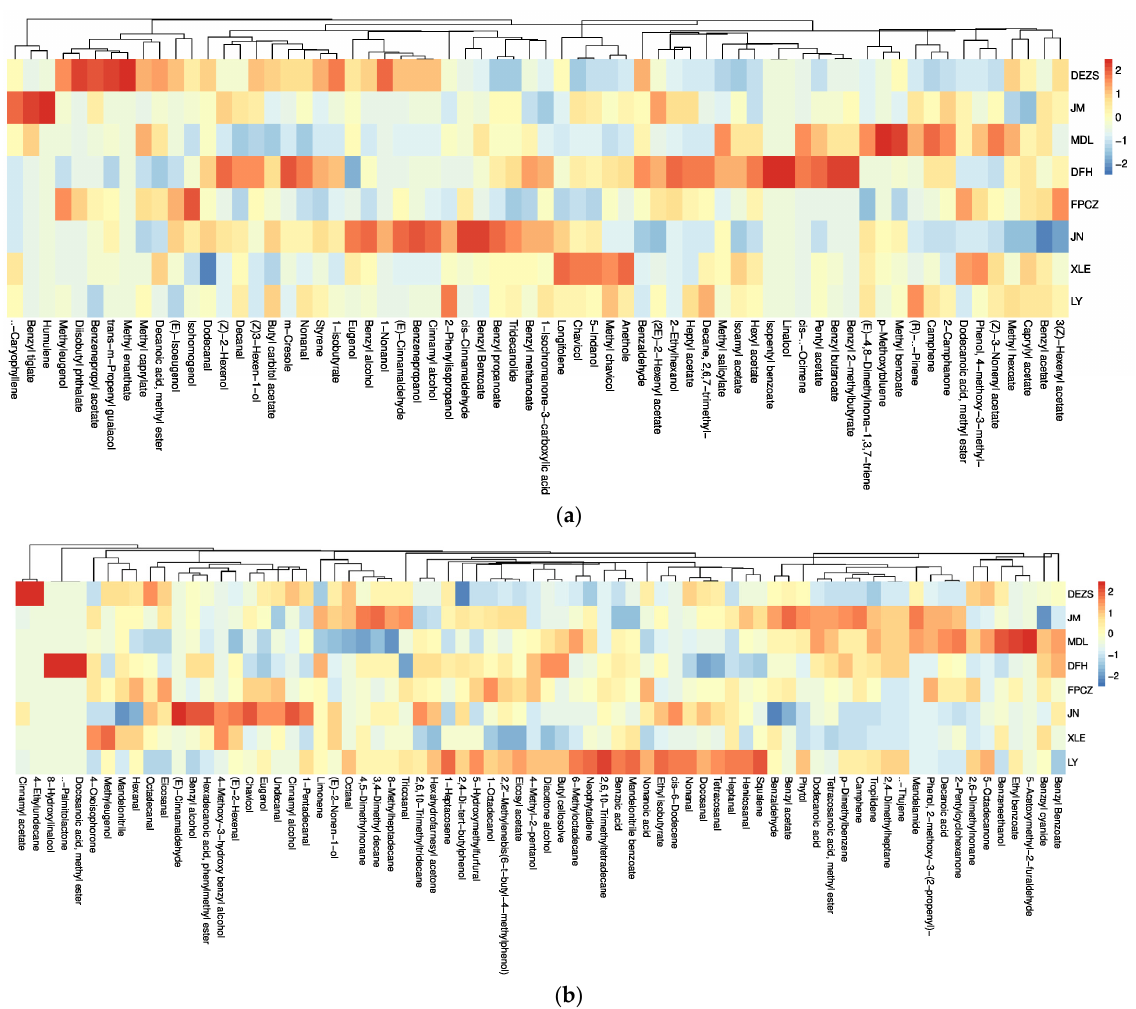
Figure 1. Heatmap and dendrogram analysis of compounds of eight P. mume cultivars with four aroma types. ( a ) headspace volatiles; ( b ) endogenous extracts. The color of the heatmap ranges from dark blue (value, − 2) to red (value, 2) in the natural logarithmic scale. Data are presented with means of biological replicates. The values were normalized by log 10 transformation. ‘DEZS’ and ‘JM’ belong to the fresh-scented P. mume cultivars; ‘MDL’ and ‘DFH’ belong to the lighted- scented P. mume cultivars; ‘FPCZ’ and ‘JN’ belong to the strong-scented P. mume cultivars; ‘XLE’ and ‘LY’ belong to the sweet-scented P. mume cultivars.